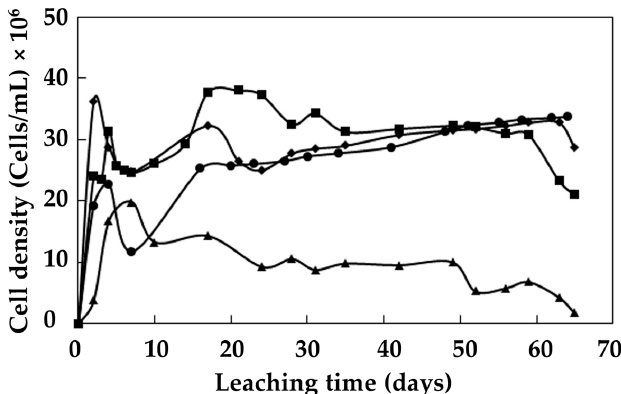
Figure 13. Evolution of cell density in the bioleaching solution of the chalcopyrite ore at ambient temperature with different raffinate solutions with 1.0 g/L total iron and continuous irrigation. ▲